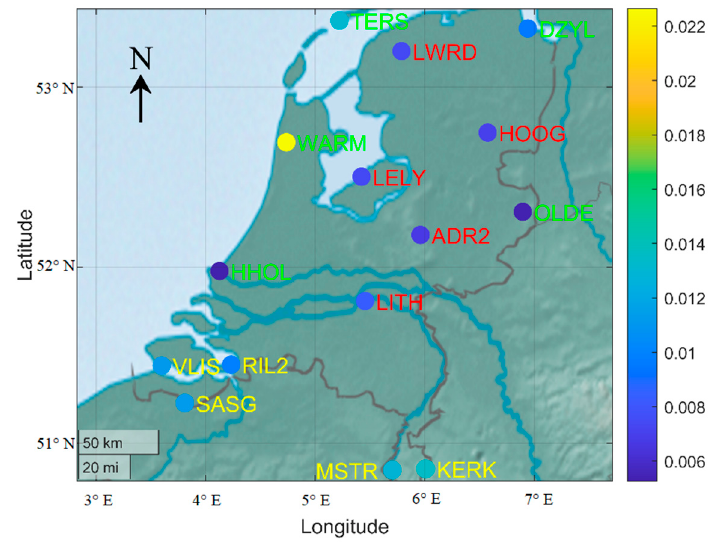
Figure 8. RMSEs of the prediction errors for the user stations on the edge of the ( a ) sparse network and ( b ) dense network.